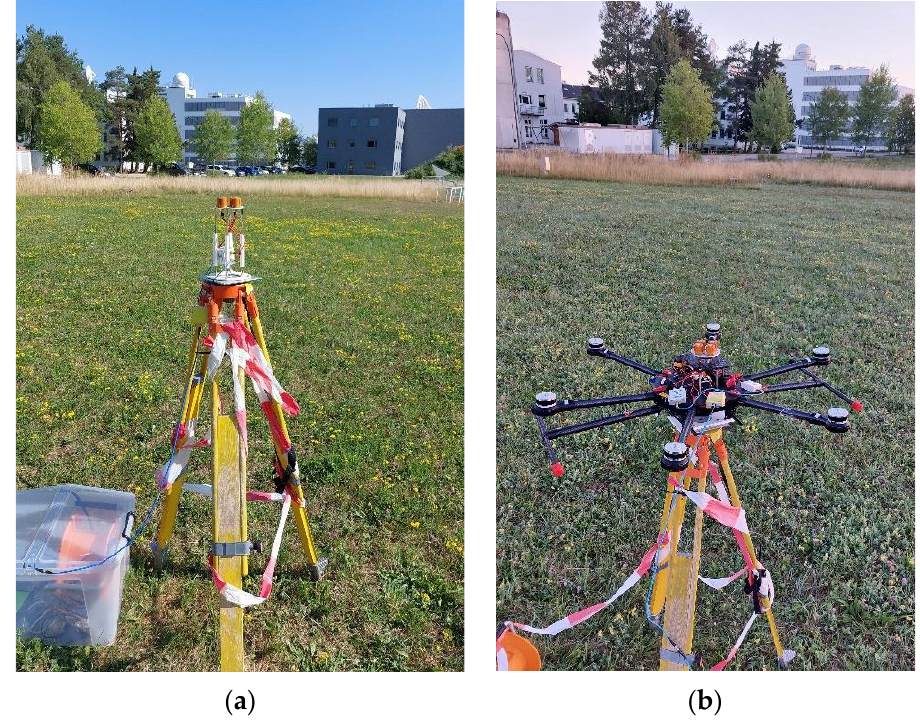
Figure 12. GNSS field measurements of the antenna array. ( a ) Standalone; ( b ) Antenna array mounted on UAV. Measurements were performed at exact same location and height above ground, only photographed from slightly different angles.